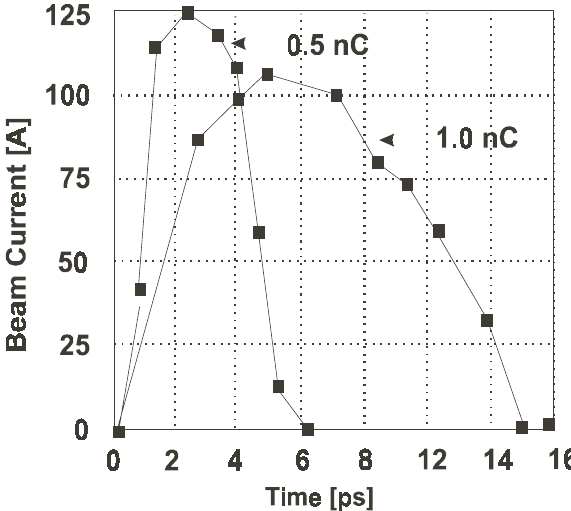
FIG. 5. Electron bunch longitudinal shape. The current is mea- sured after the e -beam monochromator upon the rf phase tuning in the linac; 1 and 0.5 nC bunches were used, correspondingly, in the first and second experiment runs. The phosphor screen, placed on the translation stage with the fiber cross, permitted observation of the e -beam spot size and intensity distribution with the same CCD camera that was used for the e -beam alignment on the cross. Figure 3 shows vertical and horizontal projections of the e -beam profile on the phosphor screen that give s b (cid:3) 50 m m. This value is close to the spatial resolution limit of the phosphor. To verify the e -beam size, we measured bremsstrahlung photons upon transverse scanning of the e beam with the 50 m m thick metal wire (see Fig. 4).